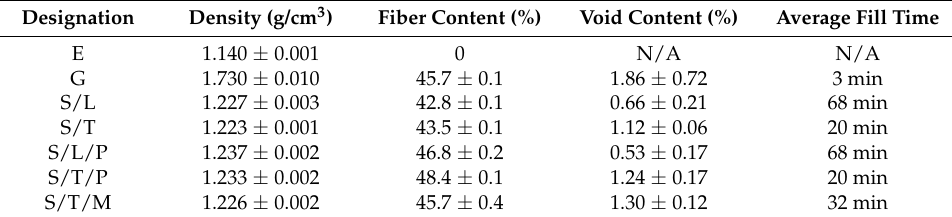
Table 2. Density, fiber content, void content, and fill time of the manufactured composite laminates (n = 10, 95% confidence